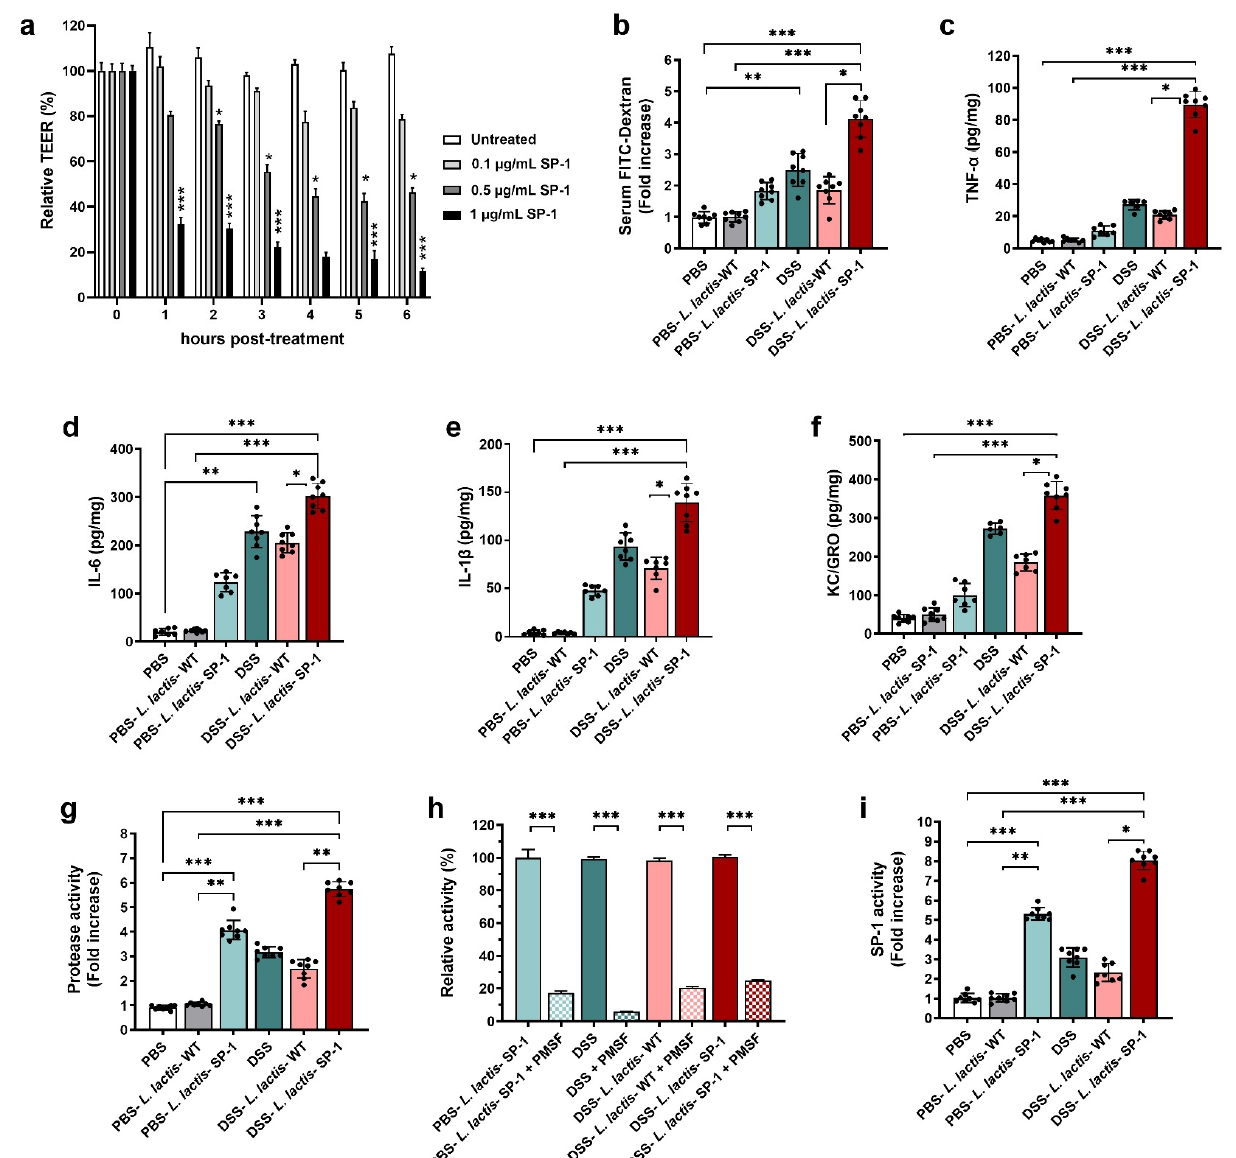
Figure 5. SP-1 supplementation impairs colonic epithelium and increases fecal protease activity. ( a ) Time-dependent means of relative changes (in %) of measured TEER ± SEM in the presence of increasing concentrations of recombinant SP-1 in comparison to untreated cells. ( b ) Epithelial barrier functions were assessed in mice by oral gavage of FITC-dextran on day 7, followed by measuring the FITC-dextran signal in blood after 3 h. ( c – f ) Colon tissues were analyzed for the concentrations of pro-inflammatory cytokines. ( g – i ) Fecal samples were analyzed for serine protease profiling. ( g ) Total fecal protease activity in each group. ( h ). Relative proteolytic activity without and with pretreatment with PMSF in PBS- L. lactis -SP-1, DSS-treated mice, DSS- L. lactis -WT and DSS- L. lactis -SP-1. The relative activity that reflects the maximal activity was defined as 100%. ( i ) Fecal SP-1 activity in PBS (N = 8), PBS- L. lactis -WT (N = 8), PBS- L. lactis -SP-1 (N = 8), DSS (N = 8), DSS- L. lactis -WT (N = 8) and DSS- L. lactis -SP-1 (N = 8). Data are presented as mean ± SEM. Statistical analyses were performed using Kruskal–Wallis, followed by the multi-comparison test of Dunn. * p < 0.05; ** p < 0.01 and *** p <